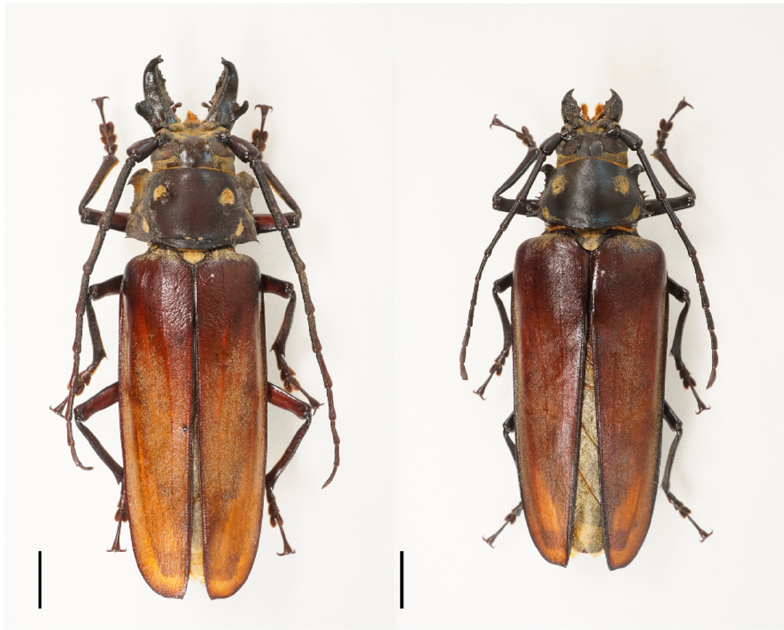
Figure 1. Habitus of Callipogon relictus , male ( left ) and female ( right ) (scale 10 mm).